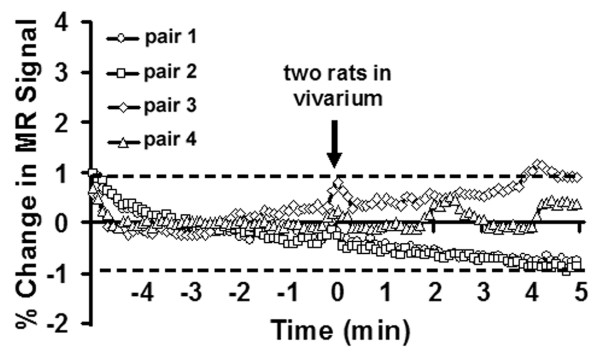
Controlling for electromagnetic interference. Shown are data from four experiments using a phantom to assess the change in MR signal over a 10 min imaging session when two adult male rats are added to the vivarium (arrow).